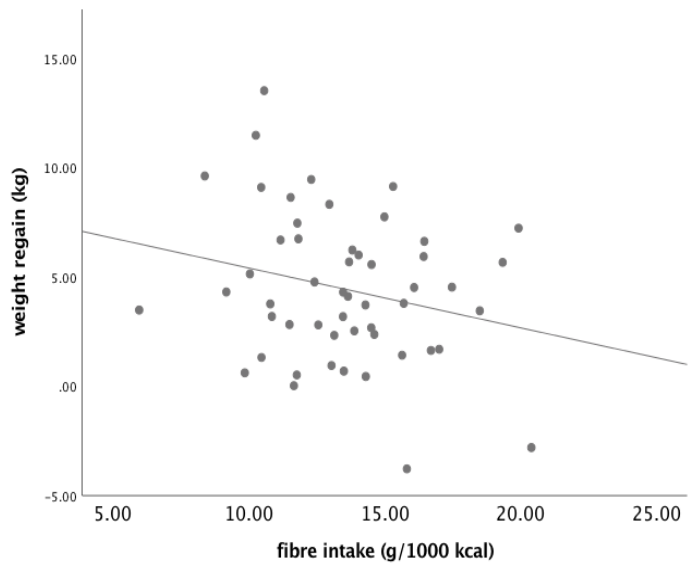
Figure 5. Association between dietary fibre intake and weight regain ( n = 49).